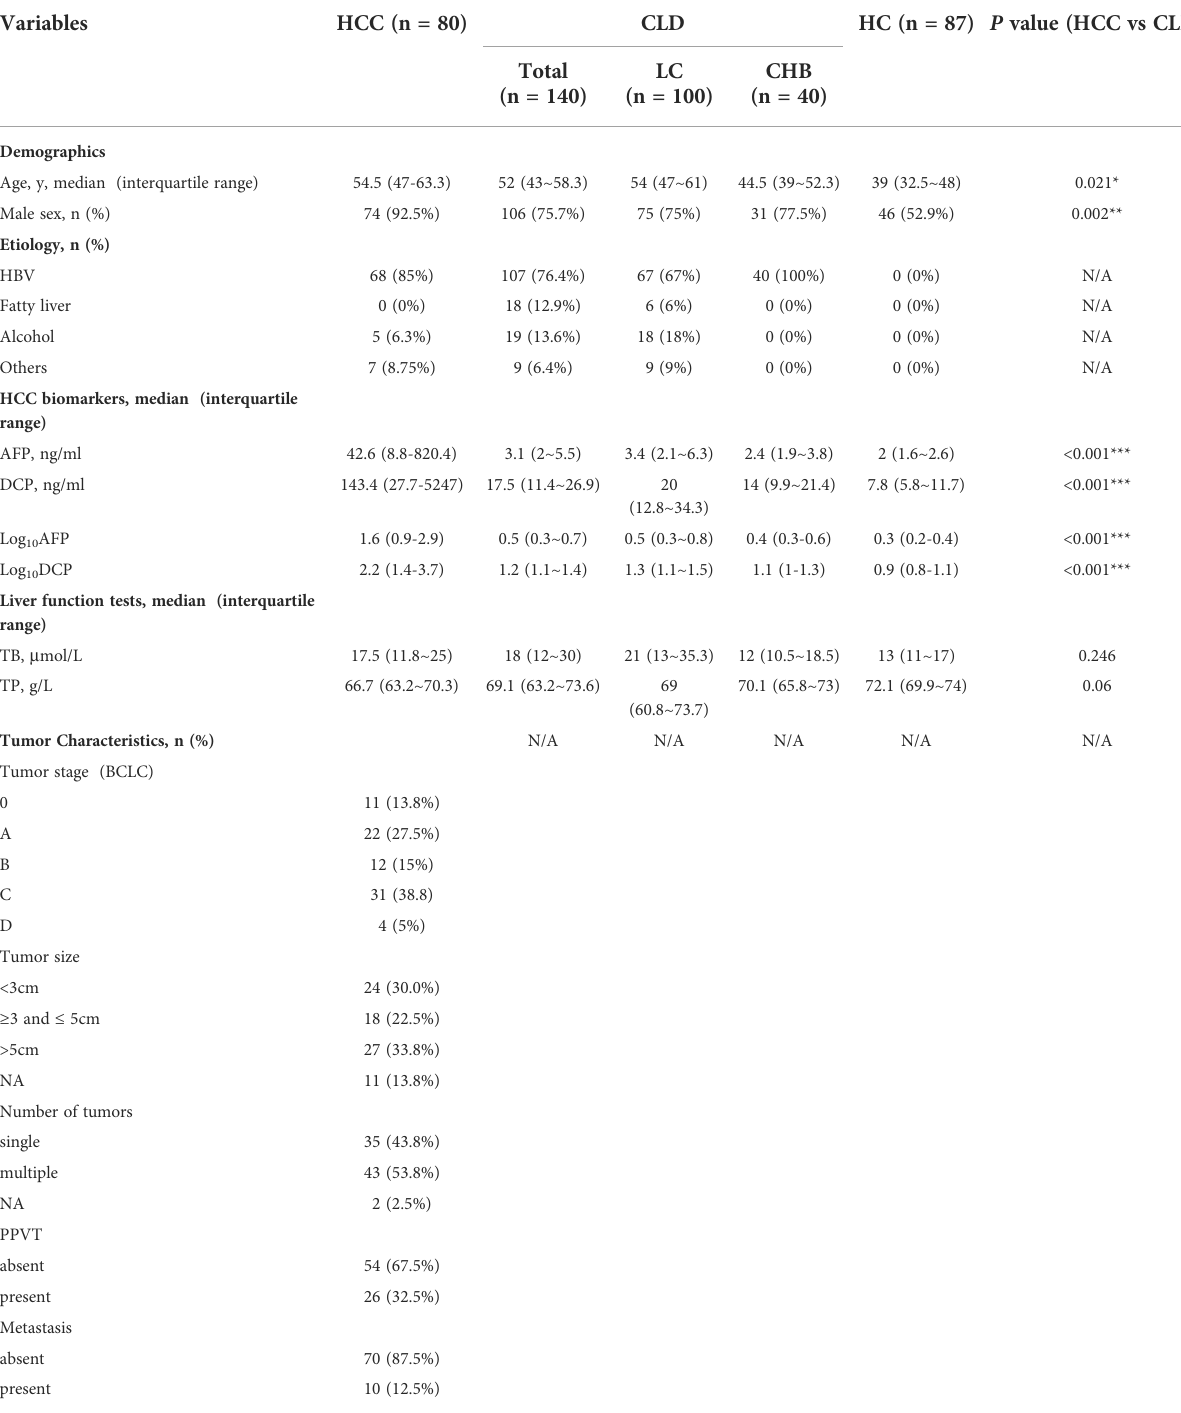
TABLE 1 Characteristics of the study participants used to develop the GAADPB